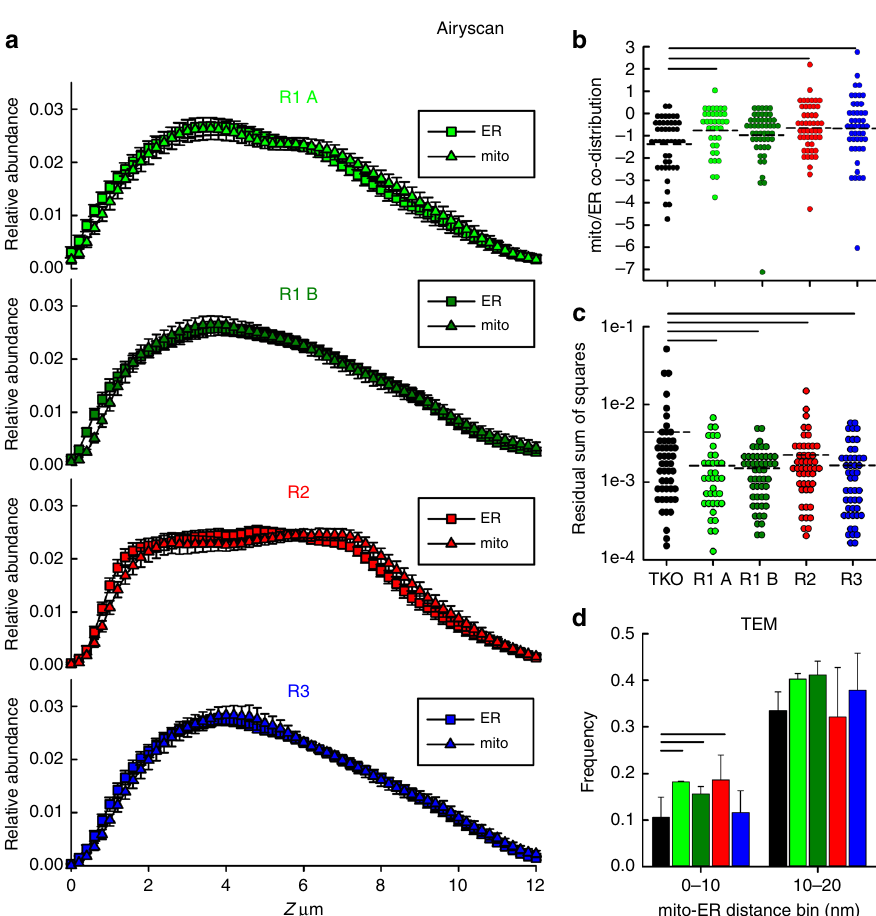
Fig. 2 Each IP3R isoform restores ER-mitochondria co-distribution and tight interactions. a Relative abundance of ER and mitochondria in R1 A ( N = 38), R1 B ( N = 50), R2 ( N = 49), and R3 ( N = 48) cells plotted against the Z -axis (mean ± SEM from four independent experiments). b Co-distribution of mitochondria and ER in the 0 – 1 µ m Z sections of each clones (Log2 converted, mean, dashed line). c Residual sum of squares for mitochondria and ER. Cellular averages (dashed lines) are compared. Black lines in b , c indicate p < 0.05 with one-way ANOVA with post-hoc Holm method. d TEM evaluation of the close interfaces between ER and mitochondria in the different IP3R rescue clones (same color code as in a ). Bar graphs show relative frequencies (Mean ± S.E.M of three experiments) of minimum distances at the interfaces of <100 nm between the ER and mitochondria in each cell line. Black lines represent p < 0.05 with Chi-squared test ( N = 238 TKO, 312 R1 A, 322 R1 B, 310 R2 and 375 R3 mitochondria from three experiments). Source data are provided for each panel as a Source Data fi